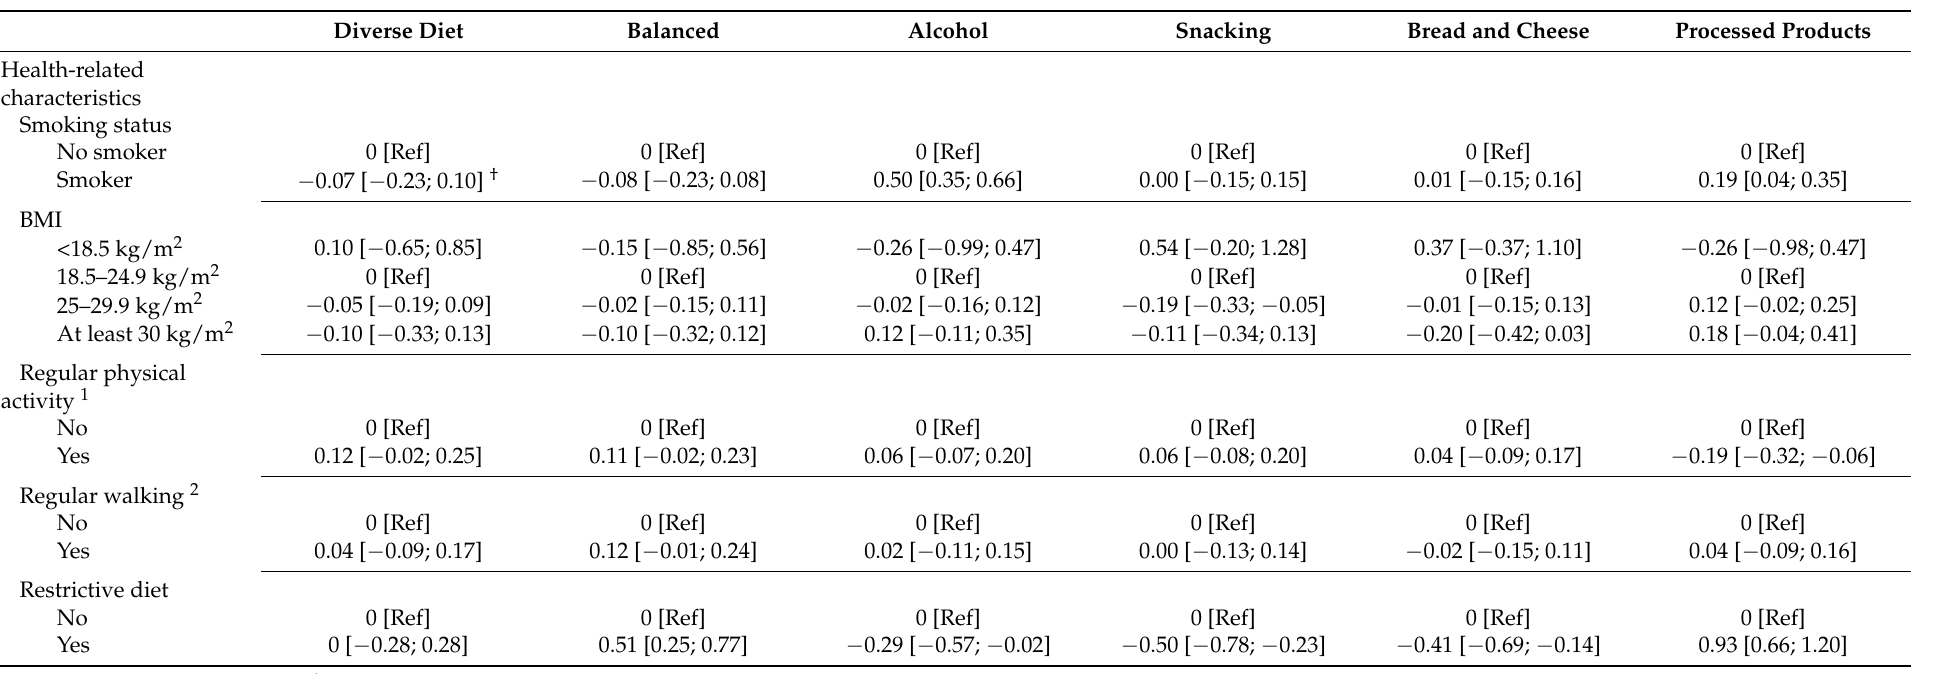
Table 4. Multivariable associations between paternal health-related characteristics and paternal diet ( n = 998): the ELFE study, 2011. Diverse Diet Balanced Alcohol Snacking Bread and Cheese Processed